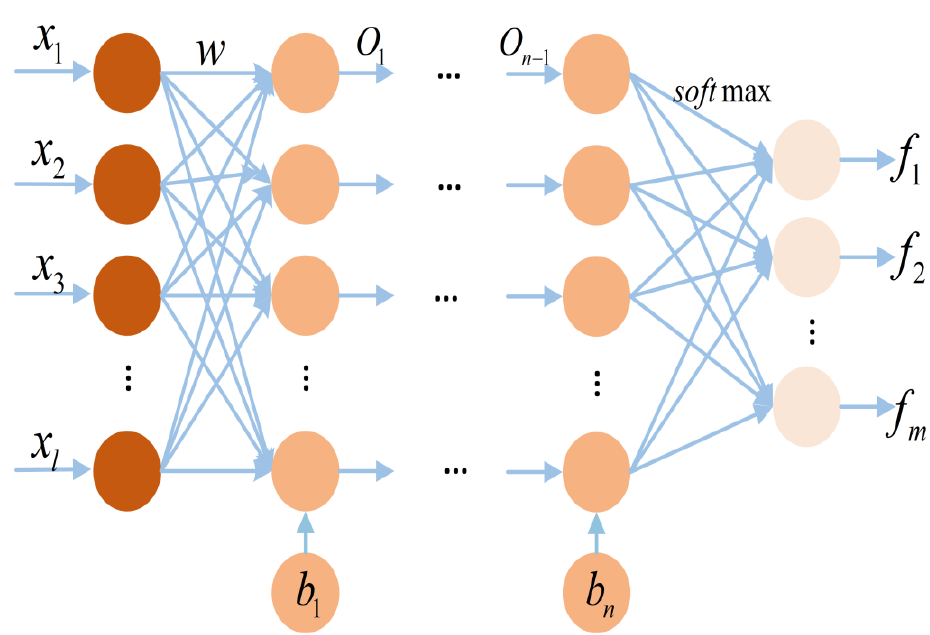
Figure 2. Architecture of MLP.